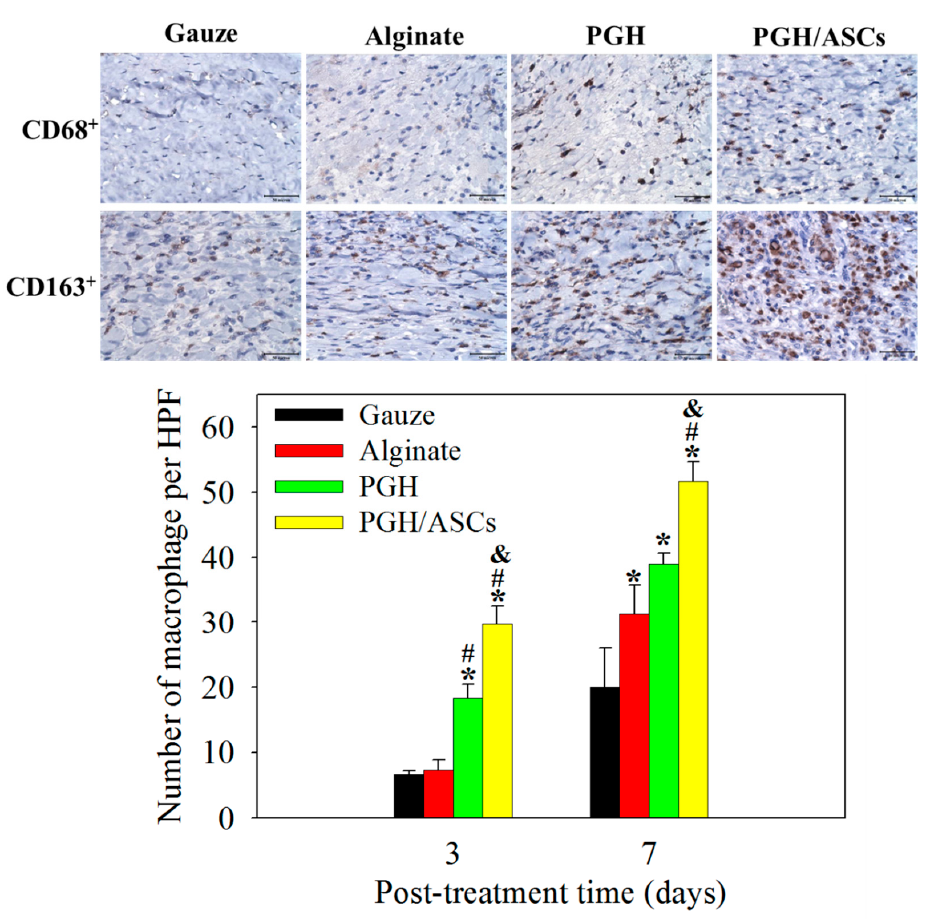
Figure 9. The representative immunohistochemical (IHC) staining images of CD68 + macrophage (day 3) and CD163 + macrophage (day 7) in wound tissues of SD rats after treatment with gauze, alginate wound dressing, PGH, or PCH/ASCs (bar = 50 μ m), and the number of macrophages per high-power field (HPF) ( n = 4). * p < 0.05 compared with gauze; # p < 0.05 compared with alginate; & p < 0.05 compared with GPH).